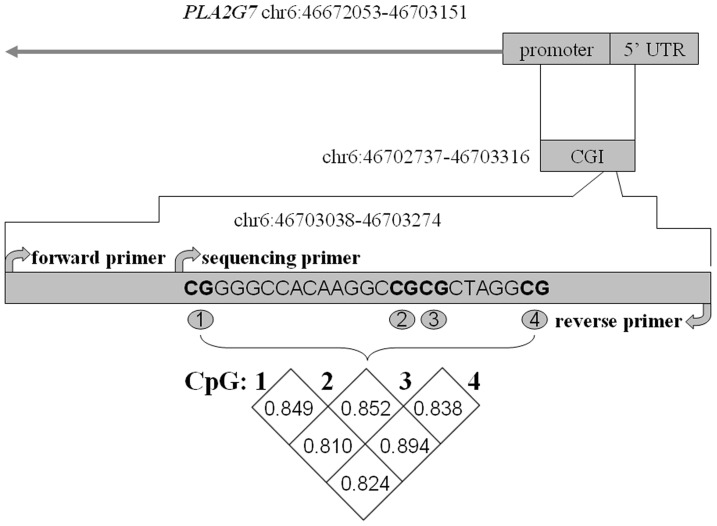
Significant correlation among the four CpGs in PLA2G7 gene promoter.